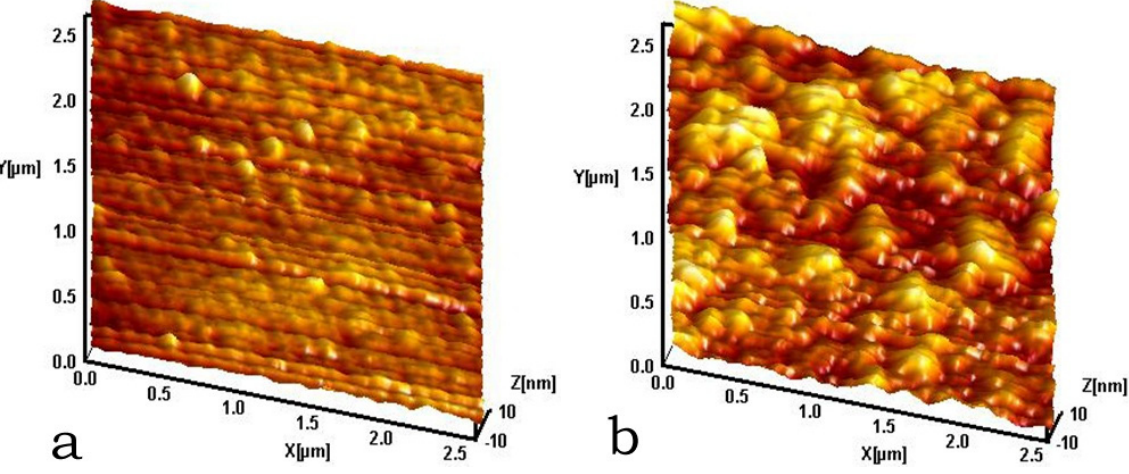
-350 and ( b ) TiO 2